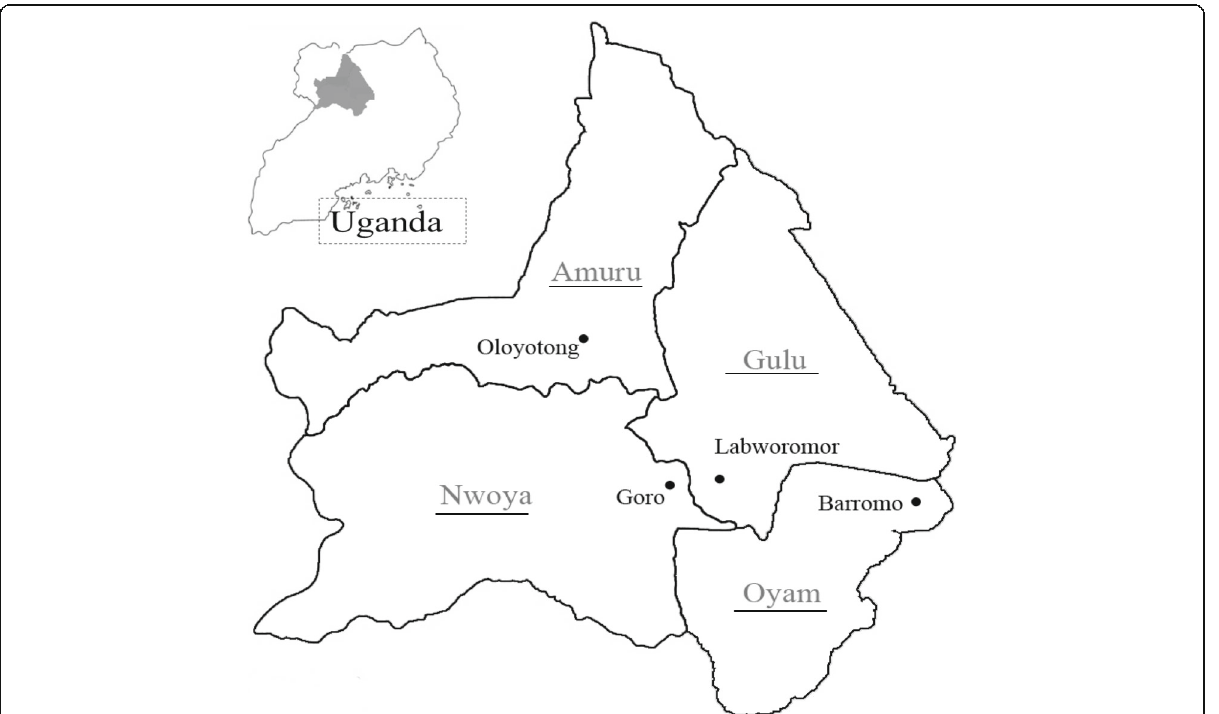
Fig. 1 Four study sites ( bullet ), Barromo, Goro, Oloyotong, and Labworomor, each in different four districts ( underlined ). The whole Uganda map is shown in the upper